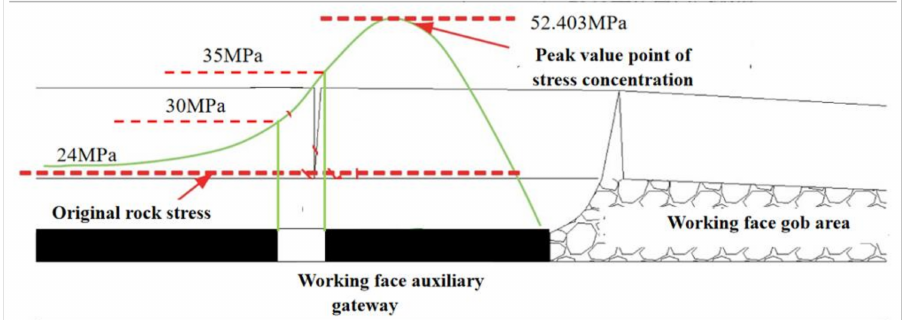
Figure 4. Stress distribution around the surrounding rock of mining-disturbed